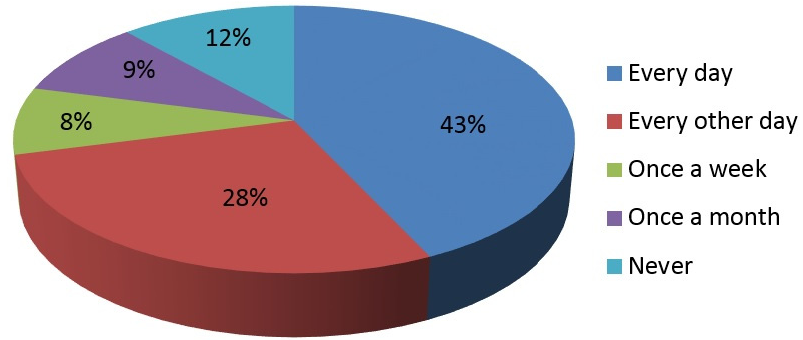
Figure 2. Frequency of use of geographic information system (GIS) applications by recent graduates from forestry programs at Mississippi State University, Oregon State University, and the University of Georgia. Table 1. GIS software used by recent graduates from forestry programs at Mississippi State University, Oregon State University, and the University of